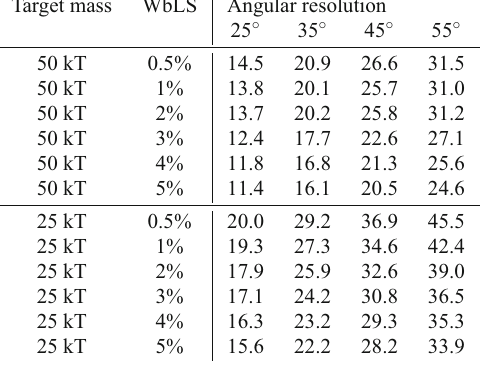
Table 8 Fit uncertainty for 5 years of data with the baseline detector configuration and the Borexino measured 40 K level in water Signal Normalization sensitivity (%) 8 B ν